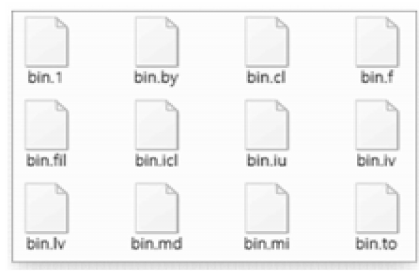
Figure 3. SNDB files generated after parsing the source navigator